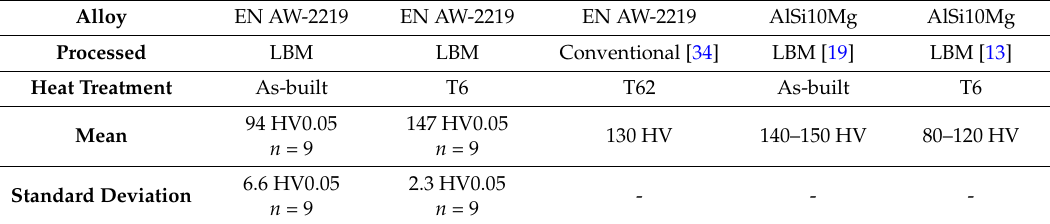
Table 3. Vickers micro-hardness HV0.05 of LBM EN AW-2219 in as-built and T6 condition compared to literature values of conventionally manufactured EN AW-2219 T62 and LBM AlSi10Mg.